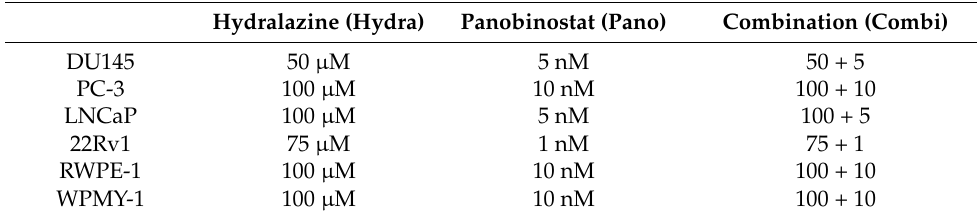
Table 1. Selected concentrations utilized in the functional assays. Each combination was selected according to each cell line EC 50 and the CI